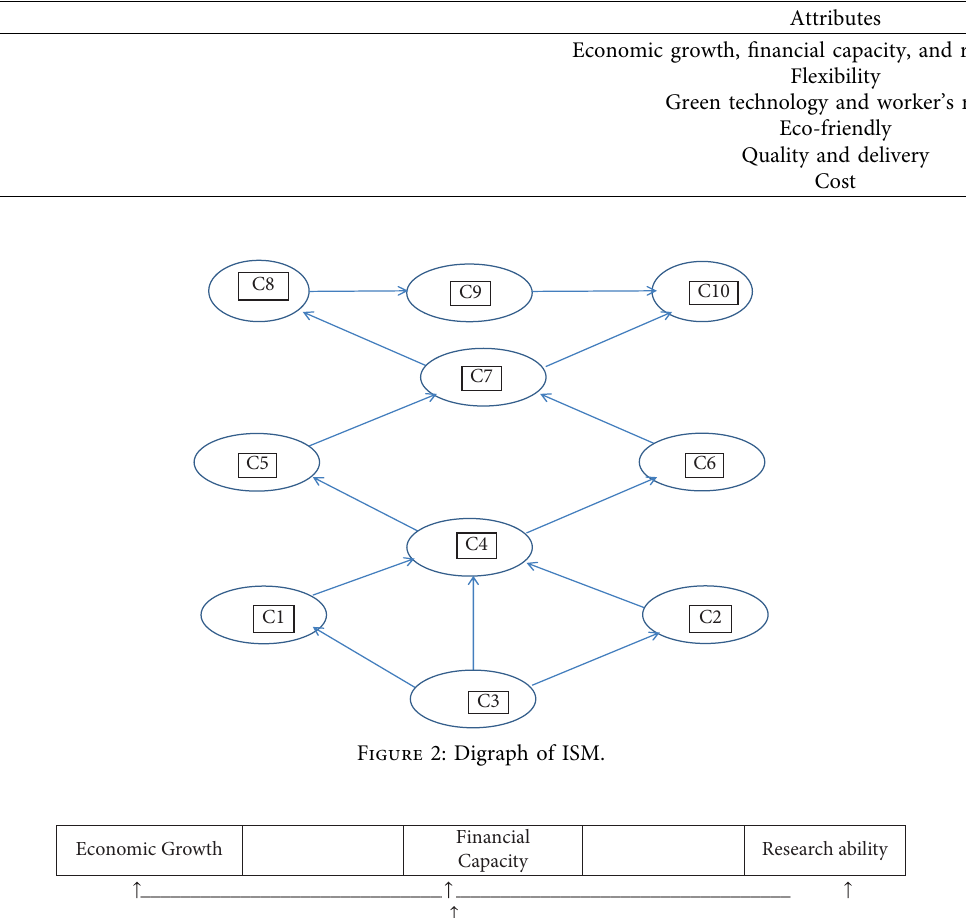
Table 7: Six levels of attributes.